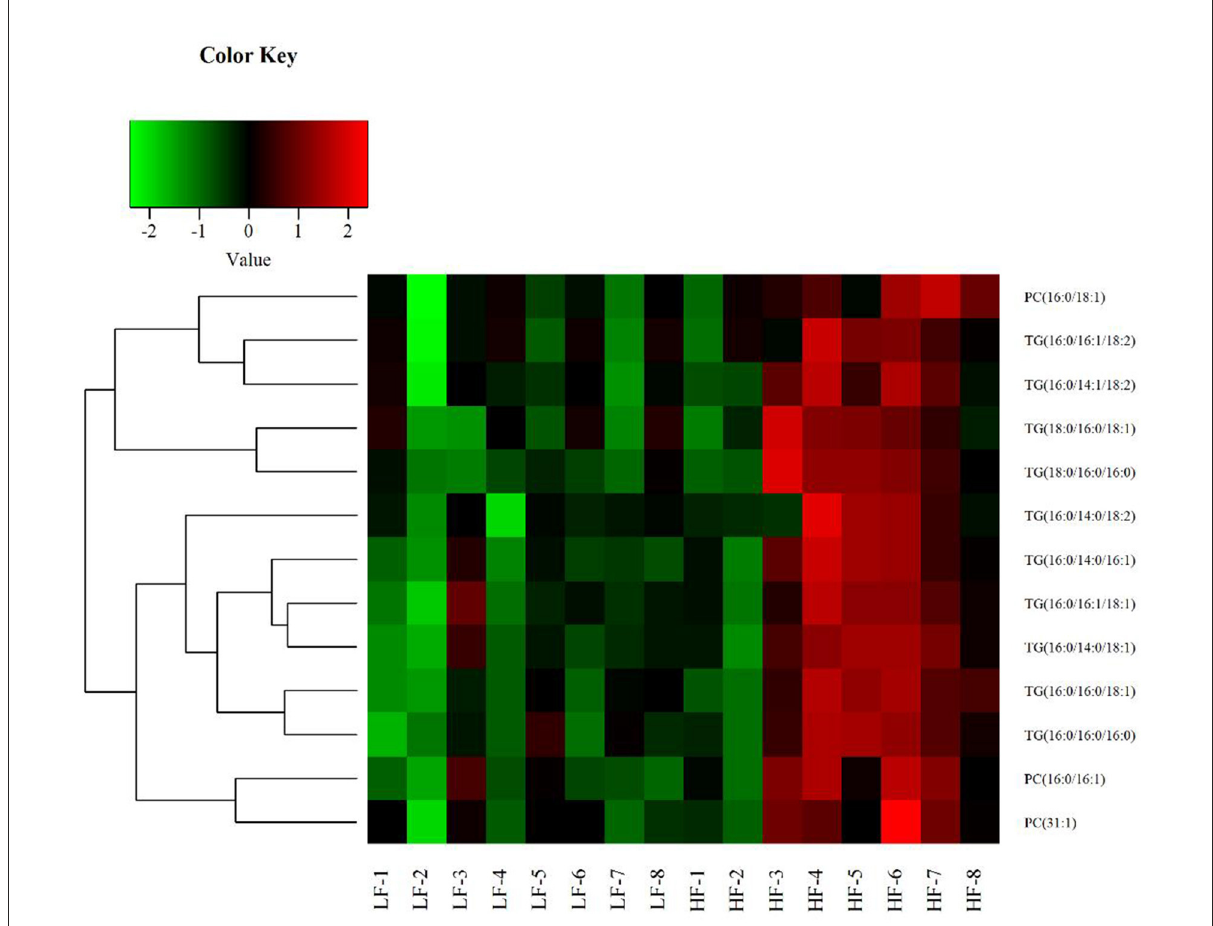
FIGURE7 Hierarchical Clustering results of significant differential lipid molecules. The greenpart represents down regulation of expression. The red part represents